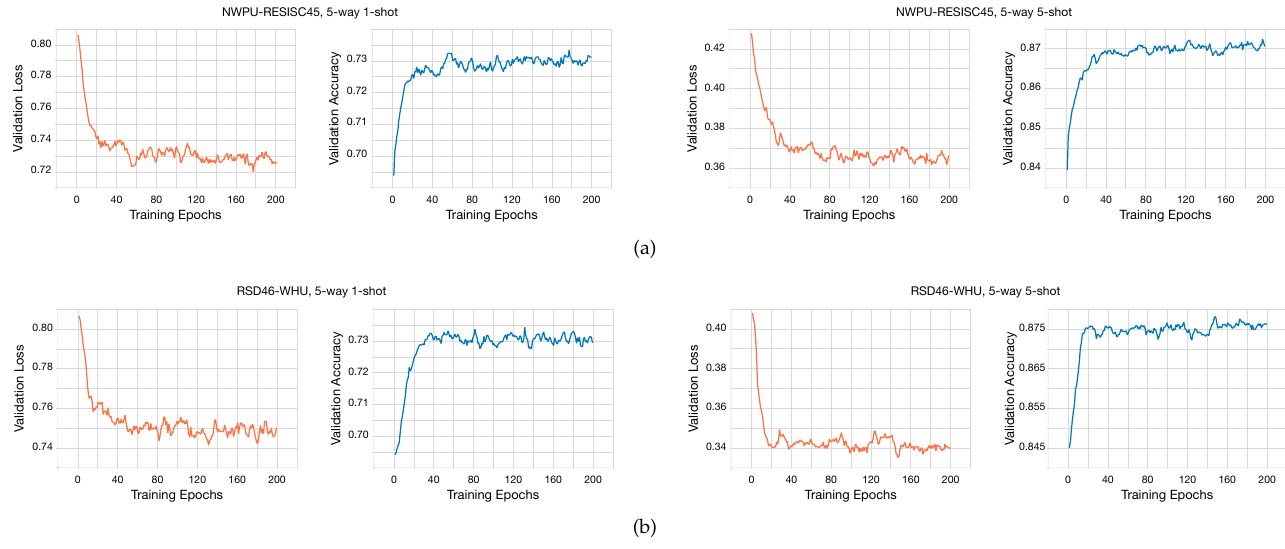
Figure 6. Meta-validation accuracy and loss curves for TAEL on ( a ) NWPU-RESISC45 5-way 1-shot and 5-way 5-shot, and ( b ) RSD46-WHU 5-way 1shot and 5-way 5-shot. All curves are smoothed with a rate of 0.8 for better